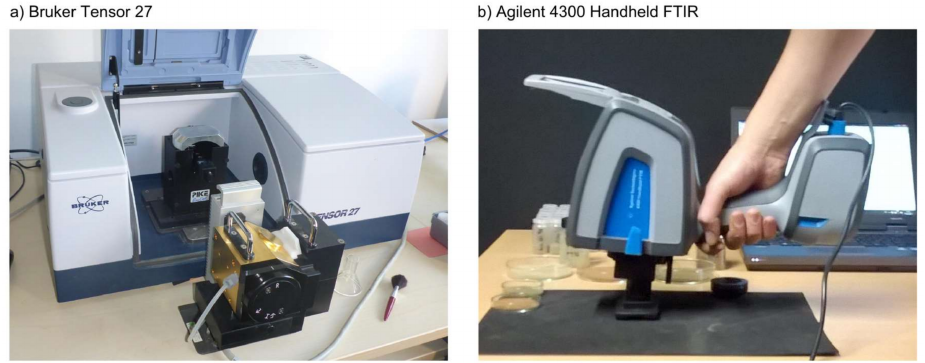
Figure 2. MIR spectrometers used in this study: ( a ) Bruker Tensor 27 bench-top instrument with EasyDiff diffuse reflectance accessory (back, in the sample compartment) and Ulbricht sphere (front); ( b ) Agilent 4300 Handheld FTIR measurement with custom sample